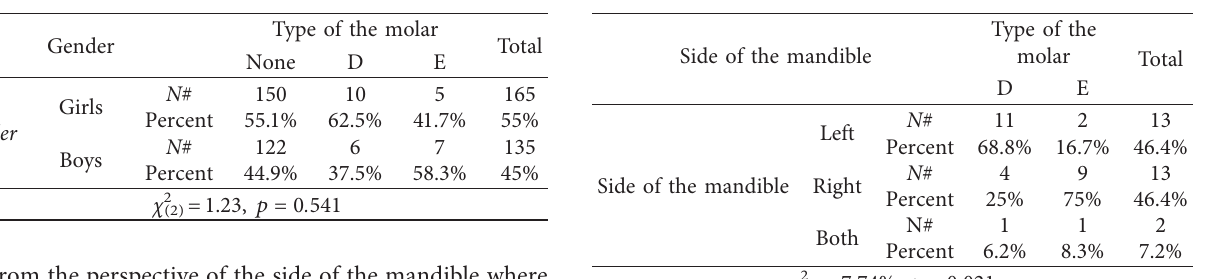
Table 1: Comparison of the frequency distribution of the type of three-rooted deciduous teeth in terms of sex.